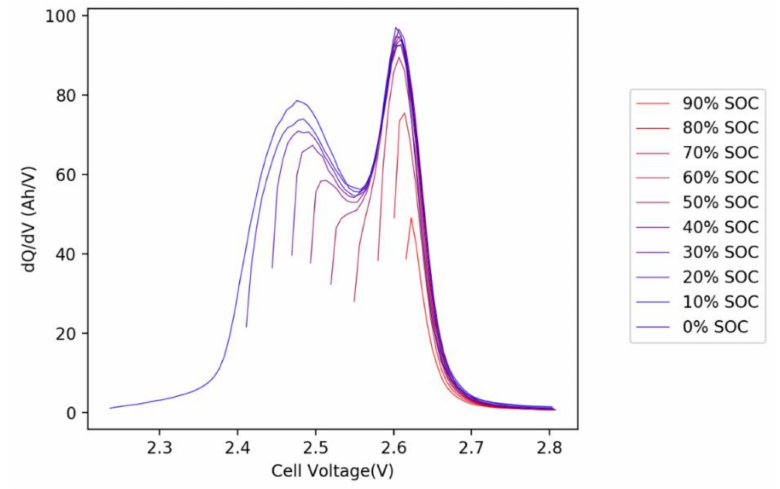
Figure 10. The IC curves of lithium titanate battery at different